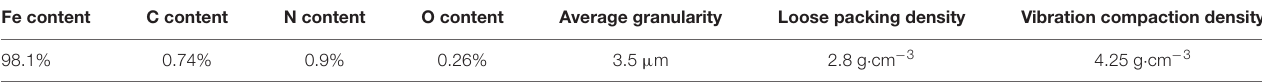
TABLE 1 | The performance index of carbonyl iron powder.